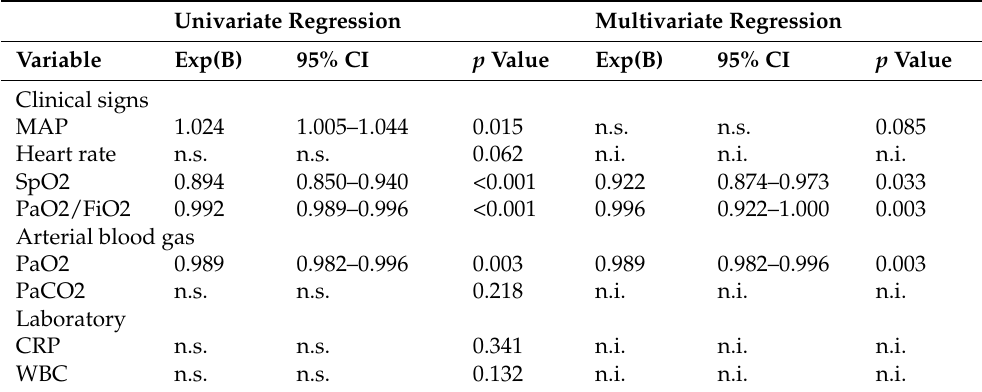
Table 5. Multivariate regression analysis of increased effort of breathing determinants. Univariate Regression Multivariate